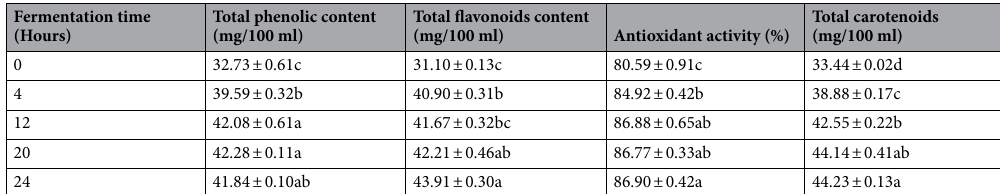
Table 4. Total phenolic content, flavonoids, antioxidant activity and carotenoids during LAB fermentation of Kanji beverage reconstituted at 10:60 concentration. Mean ± standard deviation, similar letters have no significant effect.